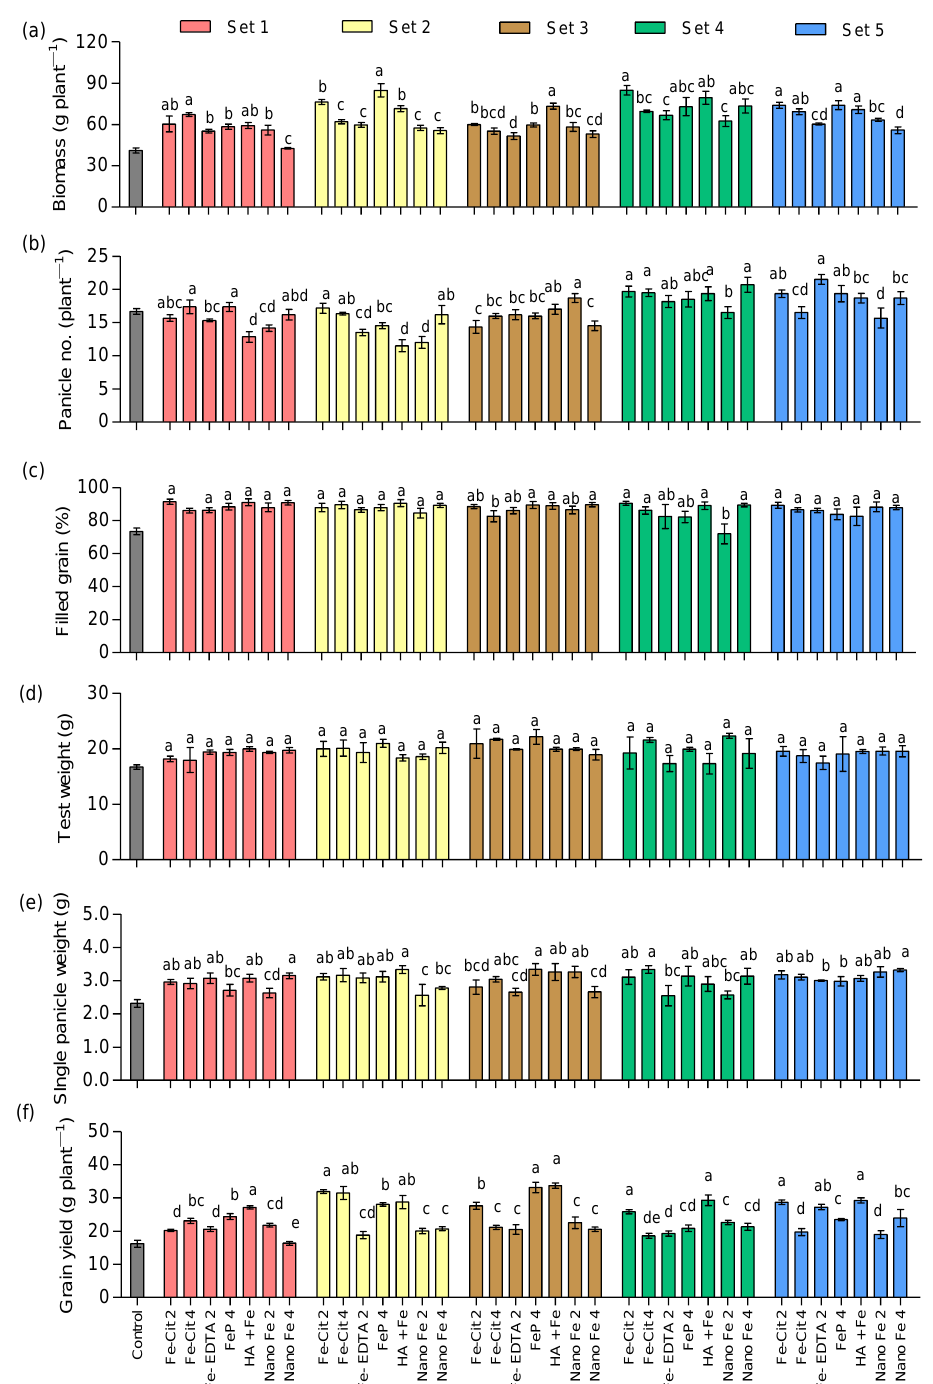
Figure 2. Influence of foliar application of Fe compounds on ( a ) total aboveground biomass, ( b ) number of panicles, ( c ) filled-grain percentage, ( d ) test weight, ( e ) single-panicle weight, and ( f ) grain yield of rice. Data correspond to means ± SEm ( n = 5). The plants of set 1, set 2, and set 3 received single sprays in the tillering, anthesis, and grain-filling stages, respectively, while set 4 plants were sprayed twice (anthesis and grain-filling stages) and set 5 plants were sprayed in all three growth stages. Each set was analyzed separately using a one-way ANOVA, and the least significant difference was calculated. Means with the same letter were not significantly different at p < 0.05. Details of the two-way ANOVA are presented in Table S2.